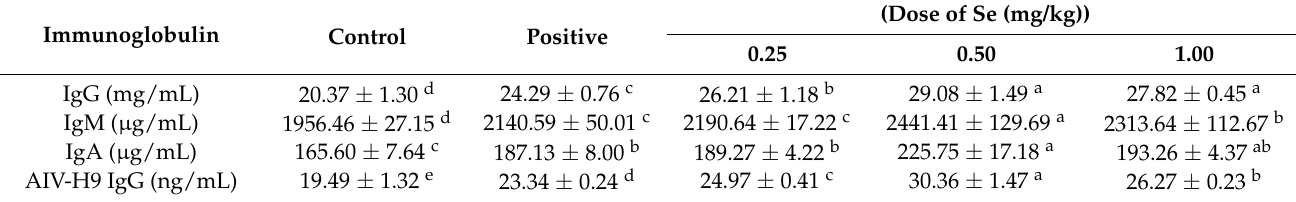
Table 4. The effect of Glycine nano-selenium on immunoglobulin after challenge experiment. (Dose of Se (mg/kg)) Immunoglobulin Control Positive 0.25 0.50